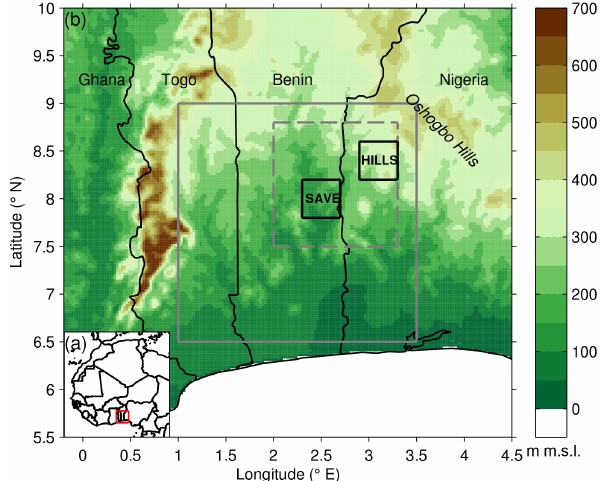
Figure 1. Location of the area of interest (red box) in West Africa (a) and orography of the area of interest in southern West Africa (b) . The model domain and the area used for the analysis are indicated by the boxes with the solid grey and dashed grey lines, respectively, and the SAVE and HILLS boxes show the areas used for detailed investigation. The city of Savè is located in the centre of